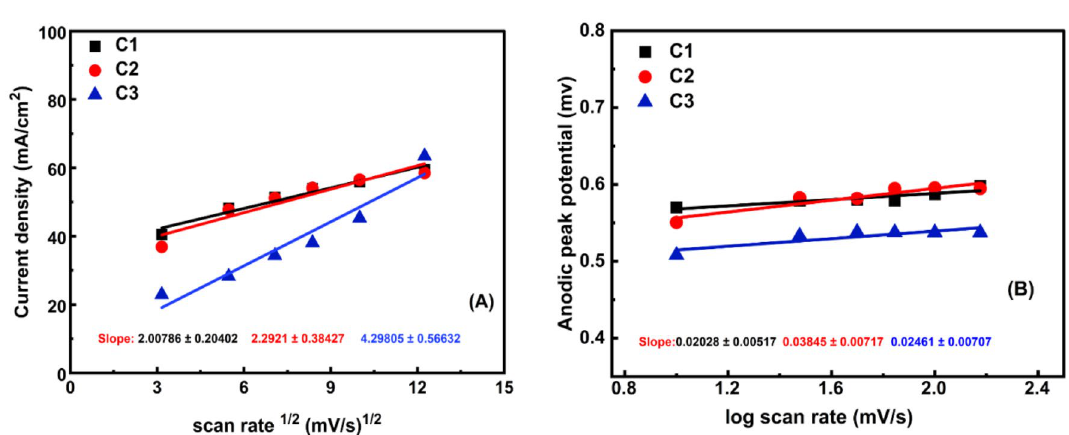
Figure 10. ( A ) Current density against scan rate 1/2 and ( B ) the logarithm of anodic peak potential versus scan rate1 in the solution of 1.0 M KOH containing 2.0 M methanol on catalysts C1, C2, and